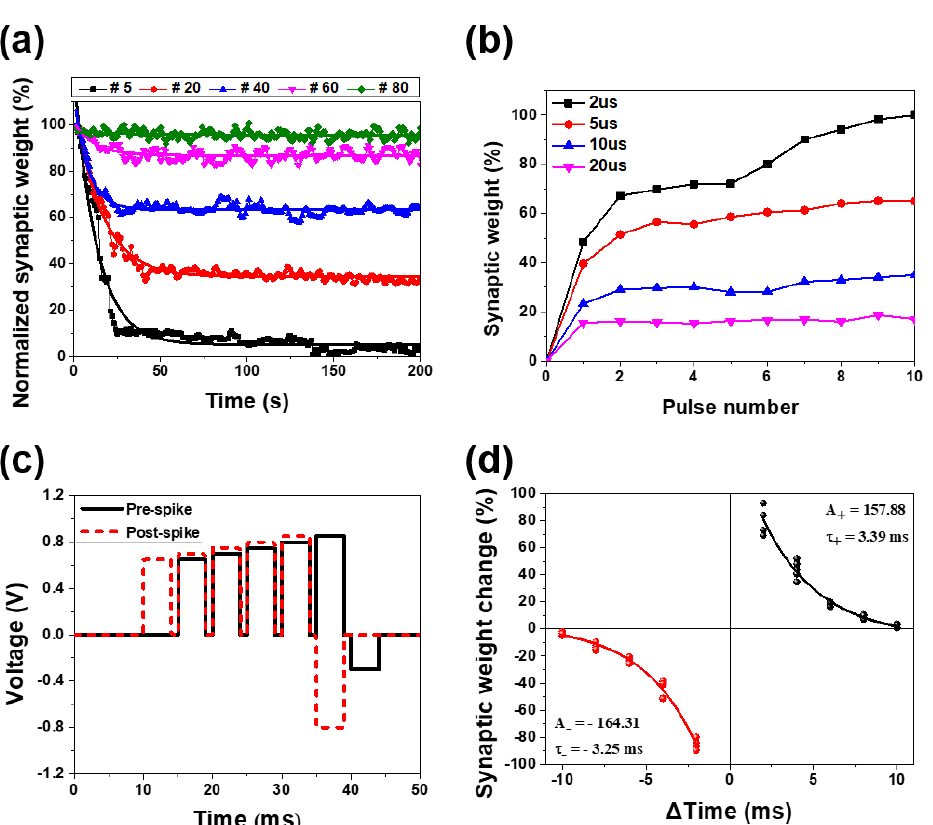
Figure 8. Variation in the synaptic weight as a function of ( a ) the retention time after the application of a different number of P-spikes, and ( b ) the number of pulses measured with P-spikes with different pulse intervals. ( c ) Pre- and post-spikes applied to PCMO memristor and ( d ) variation in Δ w with respect to Δ t .